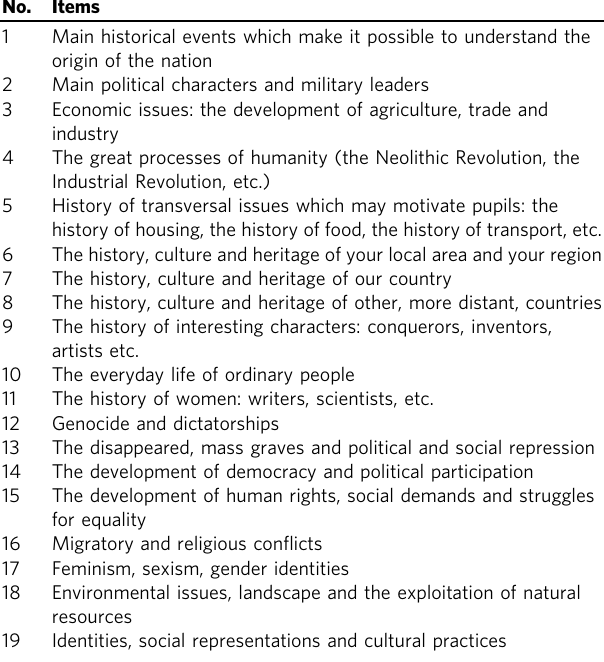
Table 3 Items from the fi rst dimension of the questionnaire. No.